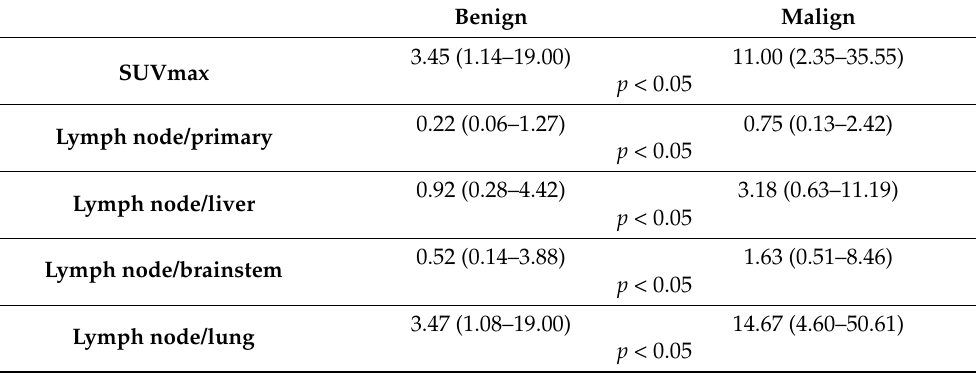
Table 2. Quantitative parameters measured in PET/CT; values shown are median and range.